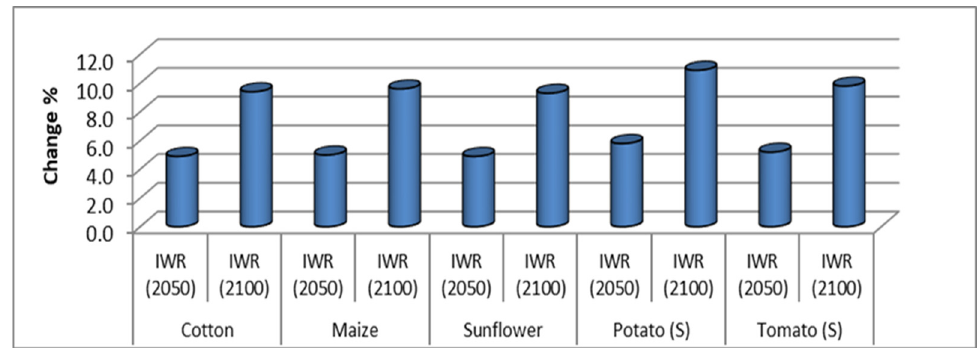
Figure 8. Change percentage in irrigation water requirements (IWR) for some main summer crops in Middle Egypt under climate change conditions compared to current conditions.